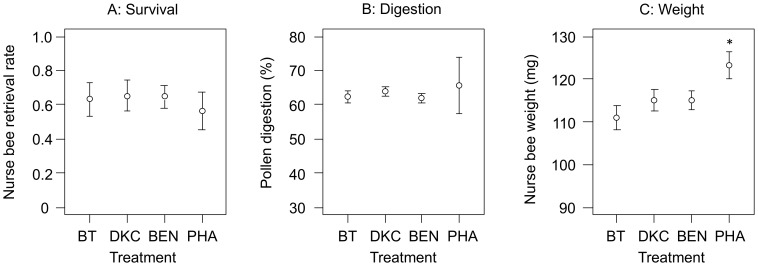
Response of nurse bees after a 9 d exposure period either to Bt maize (treatment BT), or two conventional maize cultivars (DKC, BEN), or controls with ad libitum access to different pollen sources from colonies kept at a Phacelia field (PHA).The survival (A) was indicated by the retrieval rate of marked bees, their weight (B) was determined at the moment of their retrieval. Microscopic analysis of bee hindguts was performed to calculate a weighted average degree of maize pollen digestion (C). The error bars indicate 95% confidence intervals. *indicates significant difference of a specific treatment.